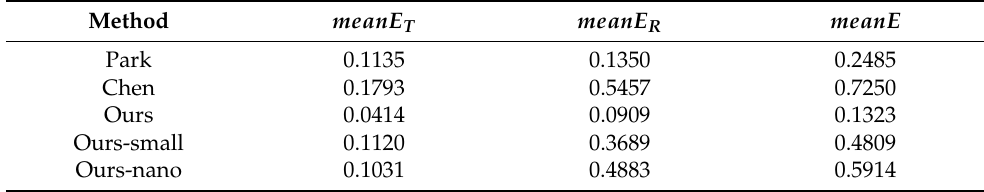
Table 2. Performance in five Real